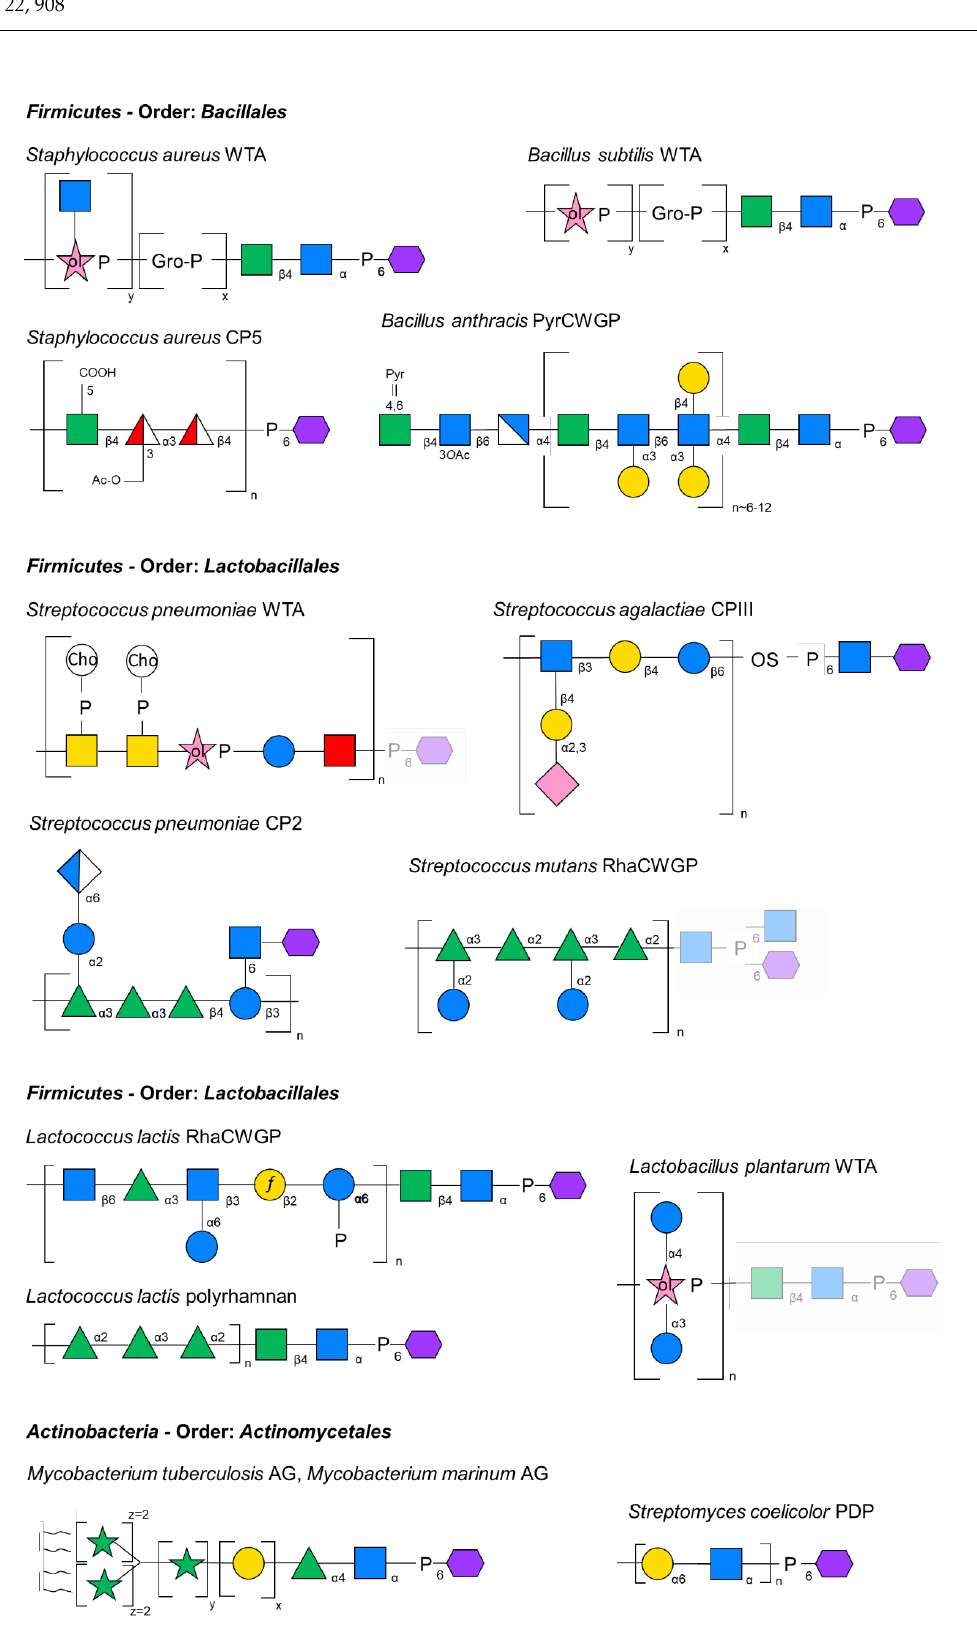
Figure 1. CWGP substrates of LCP proteins. Repeat-unit structures and the (proposed) linkage to PGN are shown, where investigated. Monosaccharide symbols are shown according to the Symbol Nomenclature for Glycans (SNFG) [32].